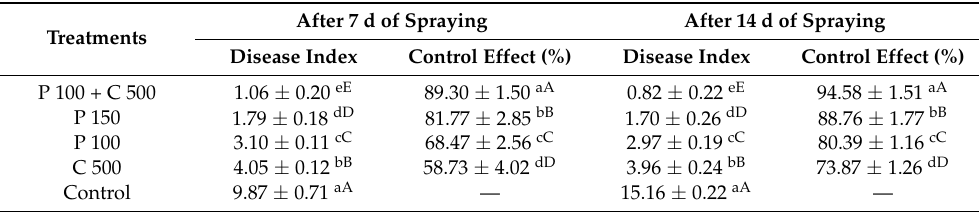
Table 2. The control effect of pyraclostrobin and chitosan against powdery mildew. After 7 d of Spraying After 14 d of Spraying Treatments Disease Index Control Effect (%)